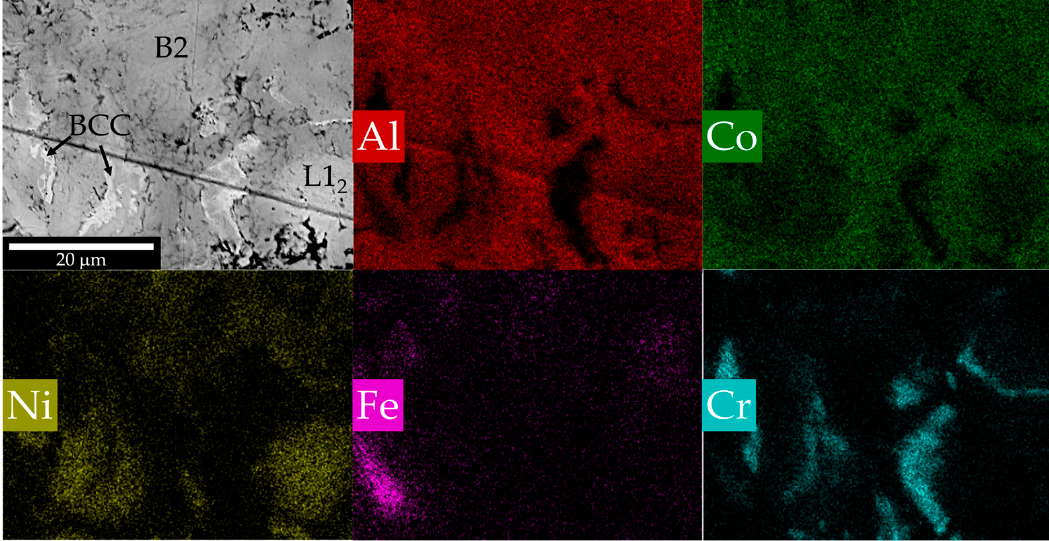
Figure 3. Cross-section and EDS element map of the powder after CS. Table 2. Chemical analysis of different phases after CS.